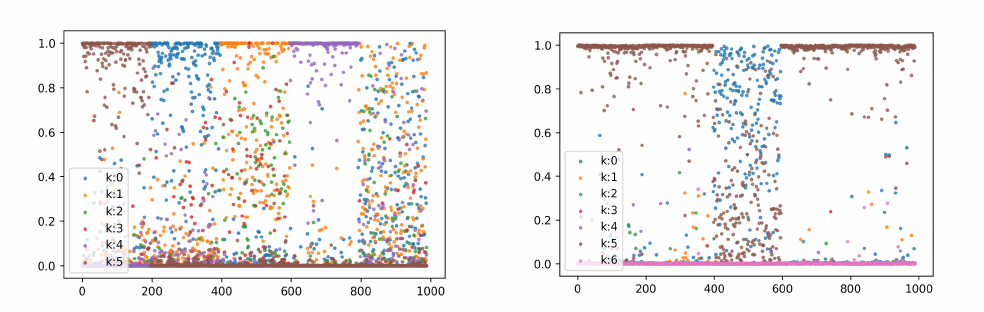
Figure 4. Document probability distributions in each topic for weighting TF-IDF ( left ) and LogTF- Entropy ( right